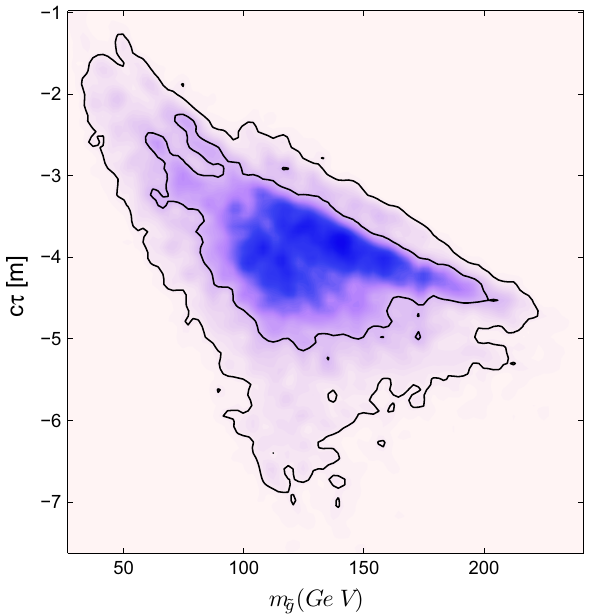
Fig. 2 Marginalised2-dimensionalposteriordistributionforthegluino decay length versus the gluino mass. The contour lines show the 68 and 95% Bayesian credibility regions